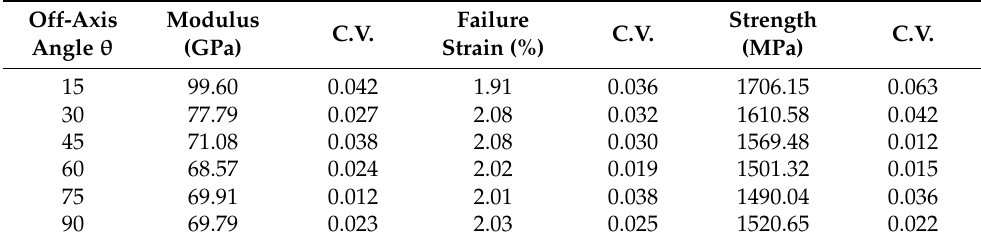
Table 2. Experimental results of the tensile strength tests of the six [0/ θ ] 2s laminates.